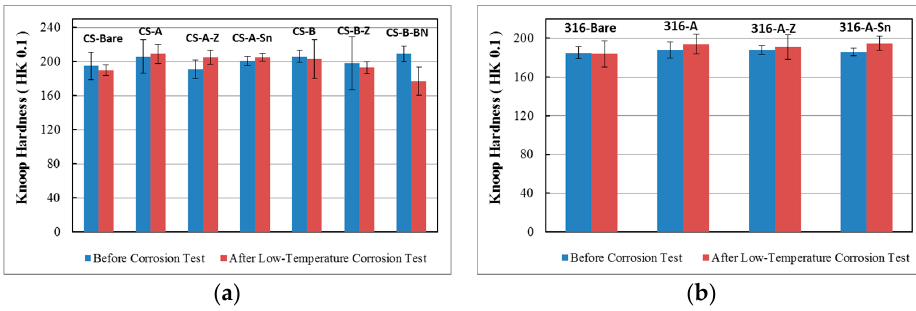
Figure 8. Comparison of Knoop hardness of the original substrate before and after the low-temperature corrosive attack for ( a ) low carbon steel, and ( b ) 316 stainless steel substrates.